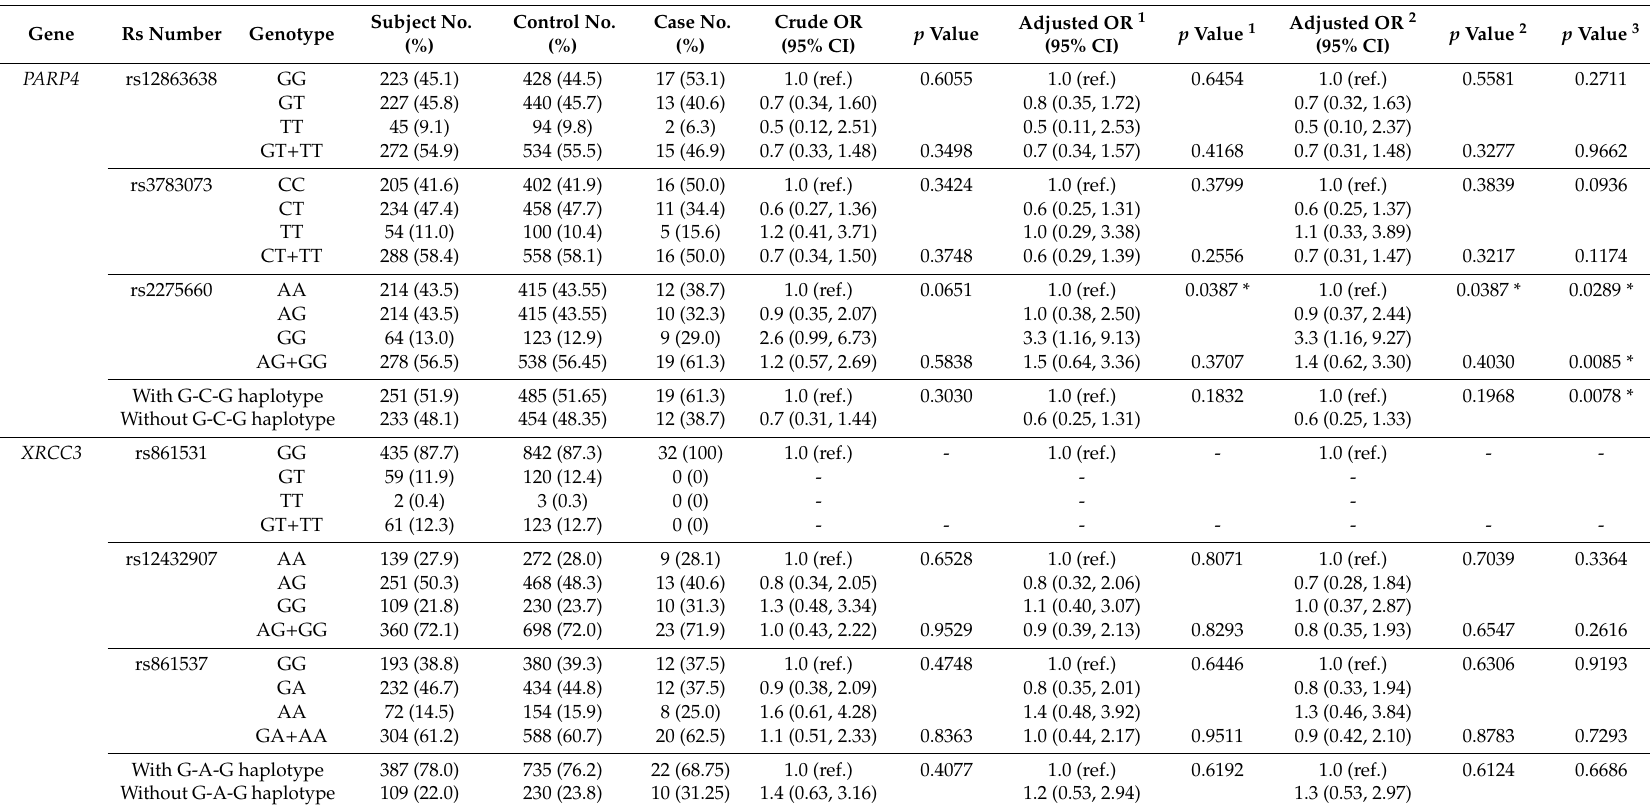
Table 7. The e ff ects of repair gene polymorphisms and combined diplotypes on liver